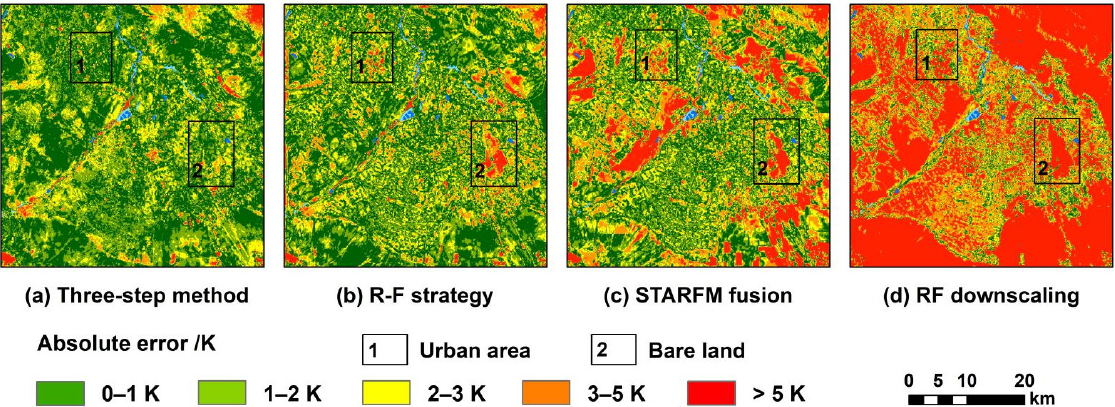
Figure 8. Distribution error maps of four predicted LST images for Image A1: ( a ) the three-step method, ( b ) the RF strategy, ( c ) the STARFM fusion, and ( d ) the RF downscaling.